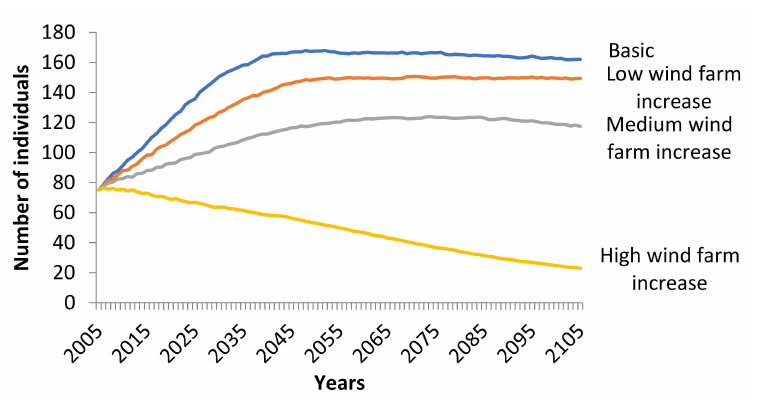
Figure 5. Trend of the Eurasian Black Vulture ( Aegypius monachus ) population under low, medium and high increase of wind farms scenarios simulated (100 years) in Southeast Europe. Increase of wind farms had an effect on all age mortality (low: +10%, medium: +20%, high: +40%). All other parameters remained stable as in the basic scenario.